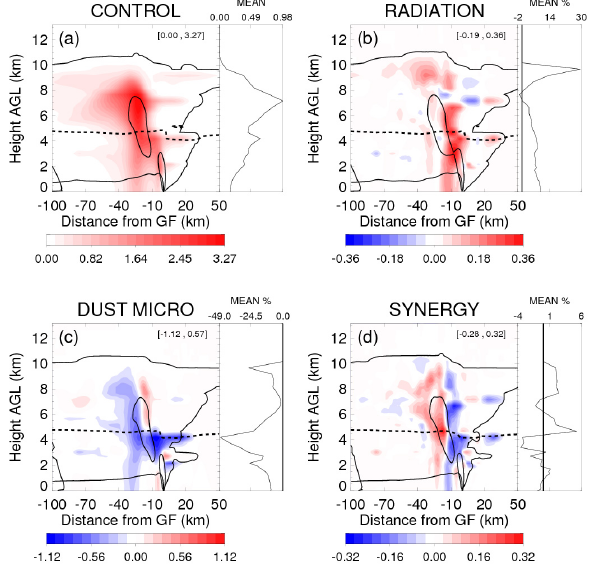
Fig. 10. Meridionally averaged along the gust front and temporally averaged total condensate mixing ratio ( total condensate ; g kg − 1 ) for (a) CONTROL, (b) RADIATION, (c) DUST MICRO, and (d) SYNERGY from sensitivity simulation hours 1–5. Each vertical cross section is expressed as a horizontal distance from the gust front (x-axis) and a vertical distance a.g.l. (y-axis). Shown on each cross section is the squall line cloud boundary (thick black line; 0.05 g kg − 1 total condensate), the freezing line (dashed black line), the cold pool boundary (thin black line below 2kma.g.l.; − 0.05 m 2 s − 2 ), the 1ms − 1 updraft region (thick black “ovals” stemming from the gust front), and (min, max) values for total condensate. The cloud boundary, freezing level, cold pool, and updraft contours are of the simulations (a) dOffrOff, (b) dOffrOn, (c) dOnrOff, and (d) dOnrOn. Also shown is a zonally averaged vertical profile that is expressed as a percent contribution relative to CONTROL (line plot) for each